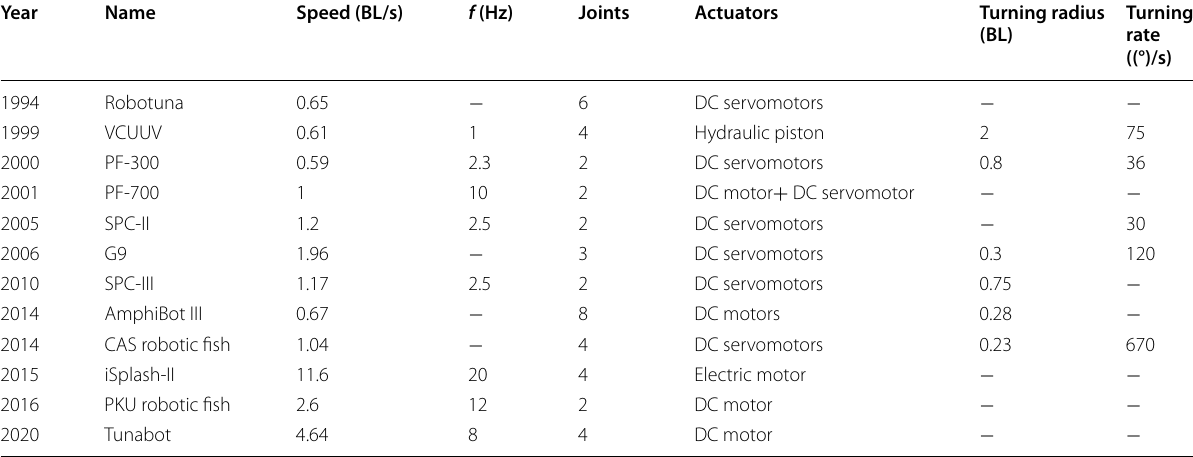
Table 4 A summary of rigid robotic